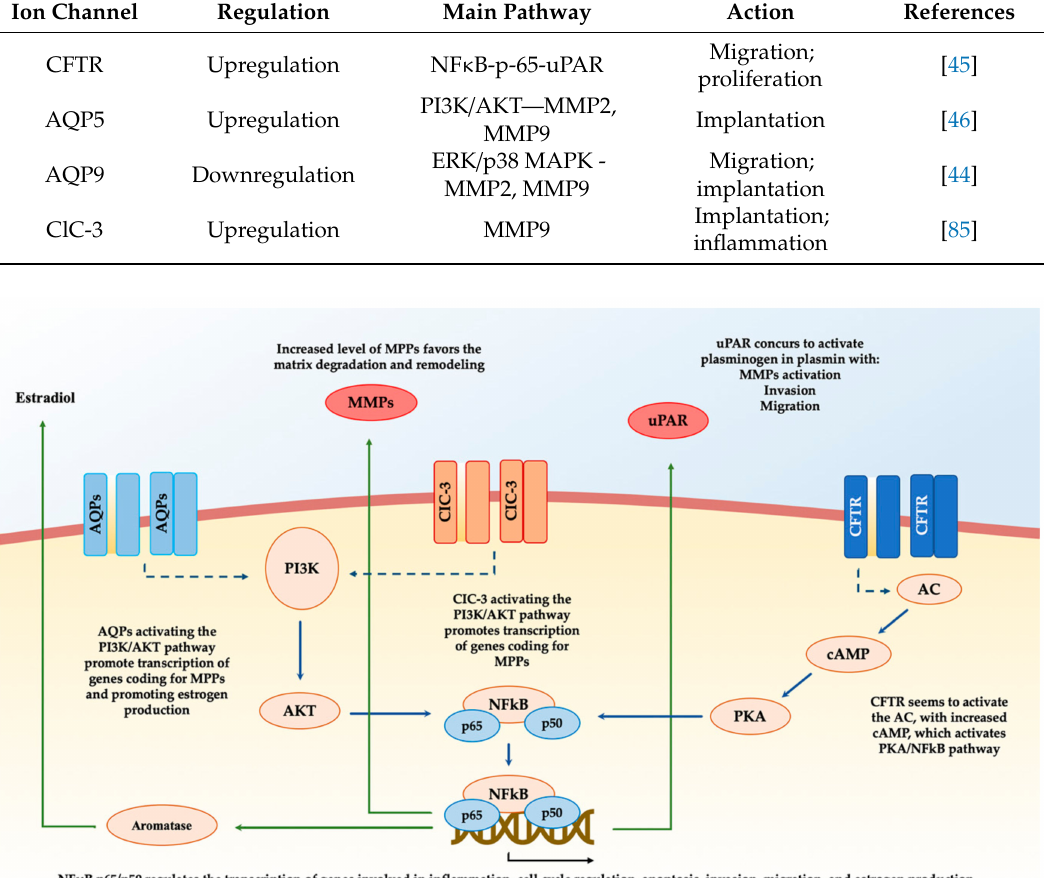
Figure 1. The main pathways involved in the pathogenesis of endometriosis mediated by ion channels. ClC-3: Chloride channel-3. AQPs: aquaporins. CFTR: cystic fibrosis transmembrane conductance regulator. AC: adenylate cyclase. cAMP: cyclical adenosine monophosphate. PKA: protein kinase A. PI3K: phosphatidylinositol-3-kinase. AKT: protein kinase B. MMPs: matrix metalloproteinases. uPAR: urokinase